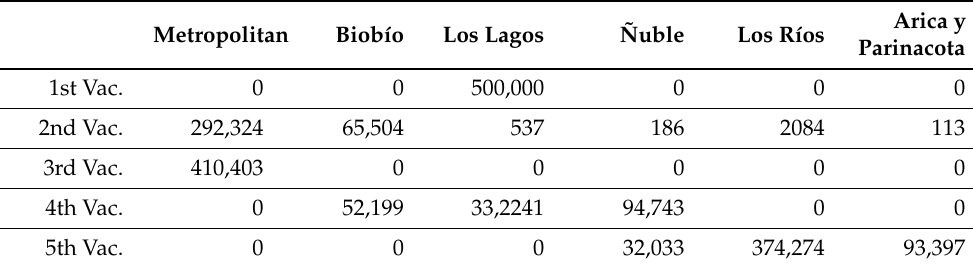
Table 13. Vaccines corresponding to the most vaccinated subdivision of the best vaccination plan obtained from SEAIRV model.